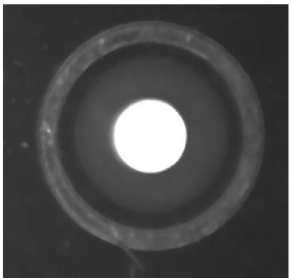
Figure 9. Marking point setting style of circuit board.